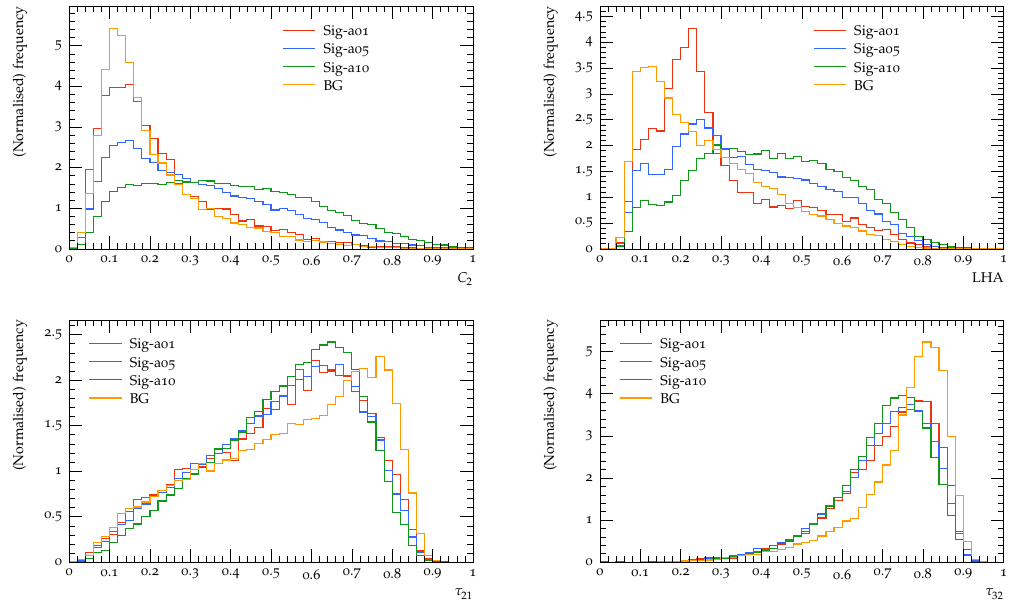
Figure 8: Comparisons of C (top left), LHA (top right), τ 2 (bottom right) between three different signals corresponding to α = 0, p and 1.0 with R range 400–600 GeV, and the background. It is interesting to inv T = 0 is not necessarily equivalent to the note that that a signal with R inv